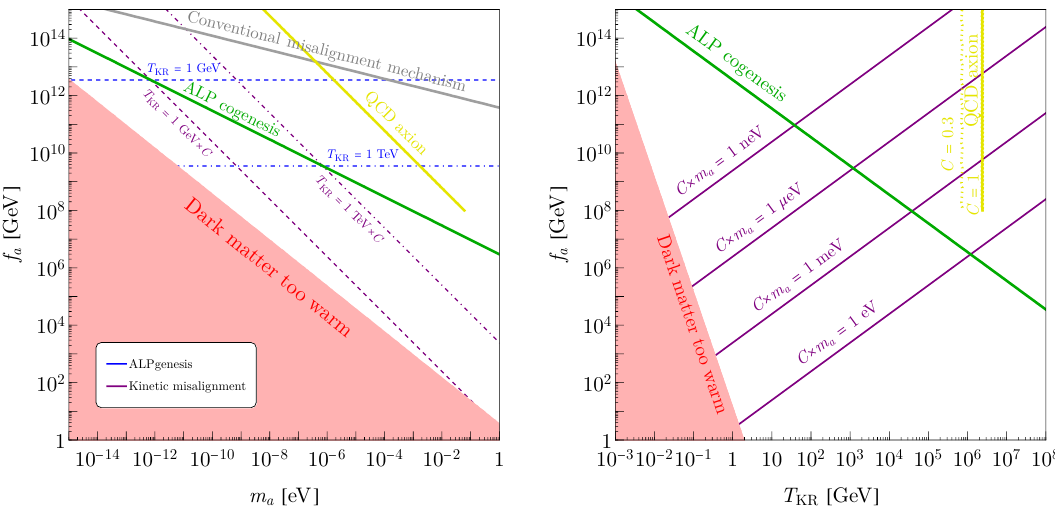
Figure 5 . Axion dark matter and the baryon asymmetry from axion rotation. Left panel: in the axion parameter space, contours of T KR = 1 GeV ( 1 TeV ) are shown in dashed (dot-dashed) lines as predicted by dark matter from kinetic misalignment (purple) and for the baryon asymmetry from minimal ALPgenesis (blue). The contours intersect along the green line where dark matter and the baryon asymmetry are simultaneously explained as in ALP cogenesis. Right panel: the purple lines are the contours of the mass of axion dark matter predicted by kinetic misalignment as a function of f a and T KR . In both panels, the red region is excluded by the warmness of axion dark matter from kinetic misalignment. The yellow line in either plot shows the prediction assuming a QCD axion which terminates at f a = 10 8 GeV since lower f a is disfavored by astrophysical